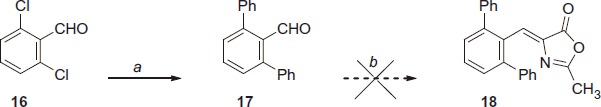
Reagents and conditions: (a) phenylboronic acid, Pd2(dba)3, Cs2CO3, Cy3P 20% toluene, dioxane, 100 °C; b) N-acetylglycine, Ac2O, CH3COONa, reflux.